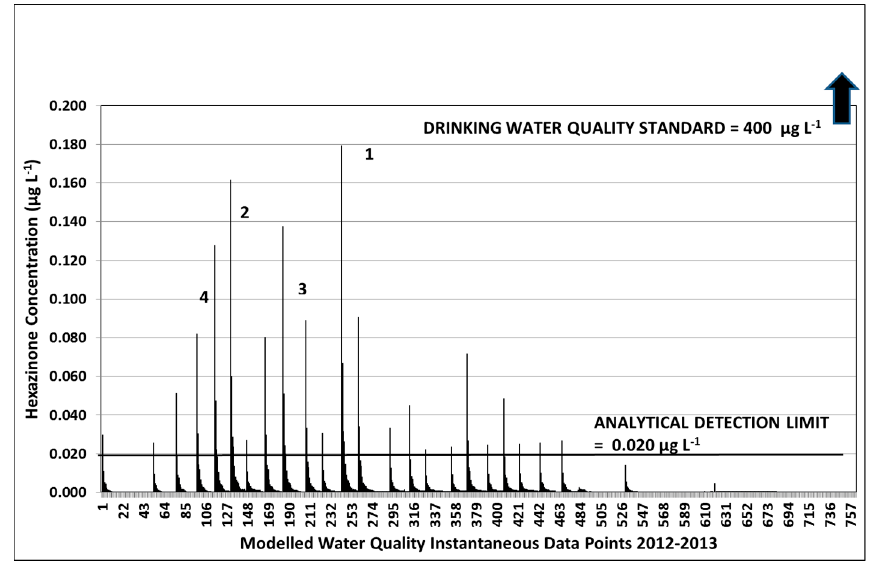
Figure 8. Year 1—modeled instantaneous concentrations of hexazinone in the Rangitaiki River at the Rangitaiki flow gauge.